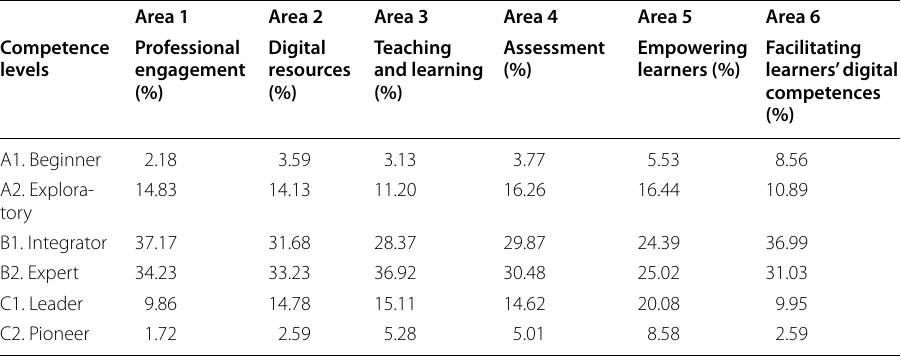
Over 60 Rather not answer 0.22 Total %acad means percentage of academics Table 8 Percentage of academics by area according to the DigCompEdu proficiency model Area 1 Area 2 Area 3 Competence Professional Digital levels engagement resources (%)